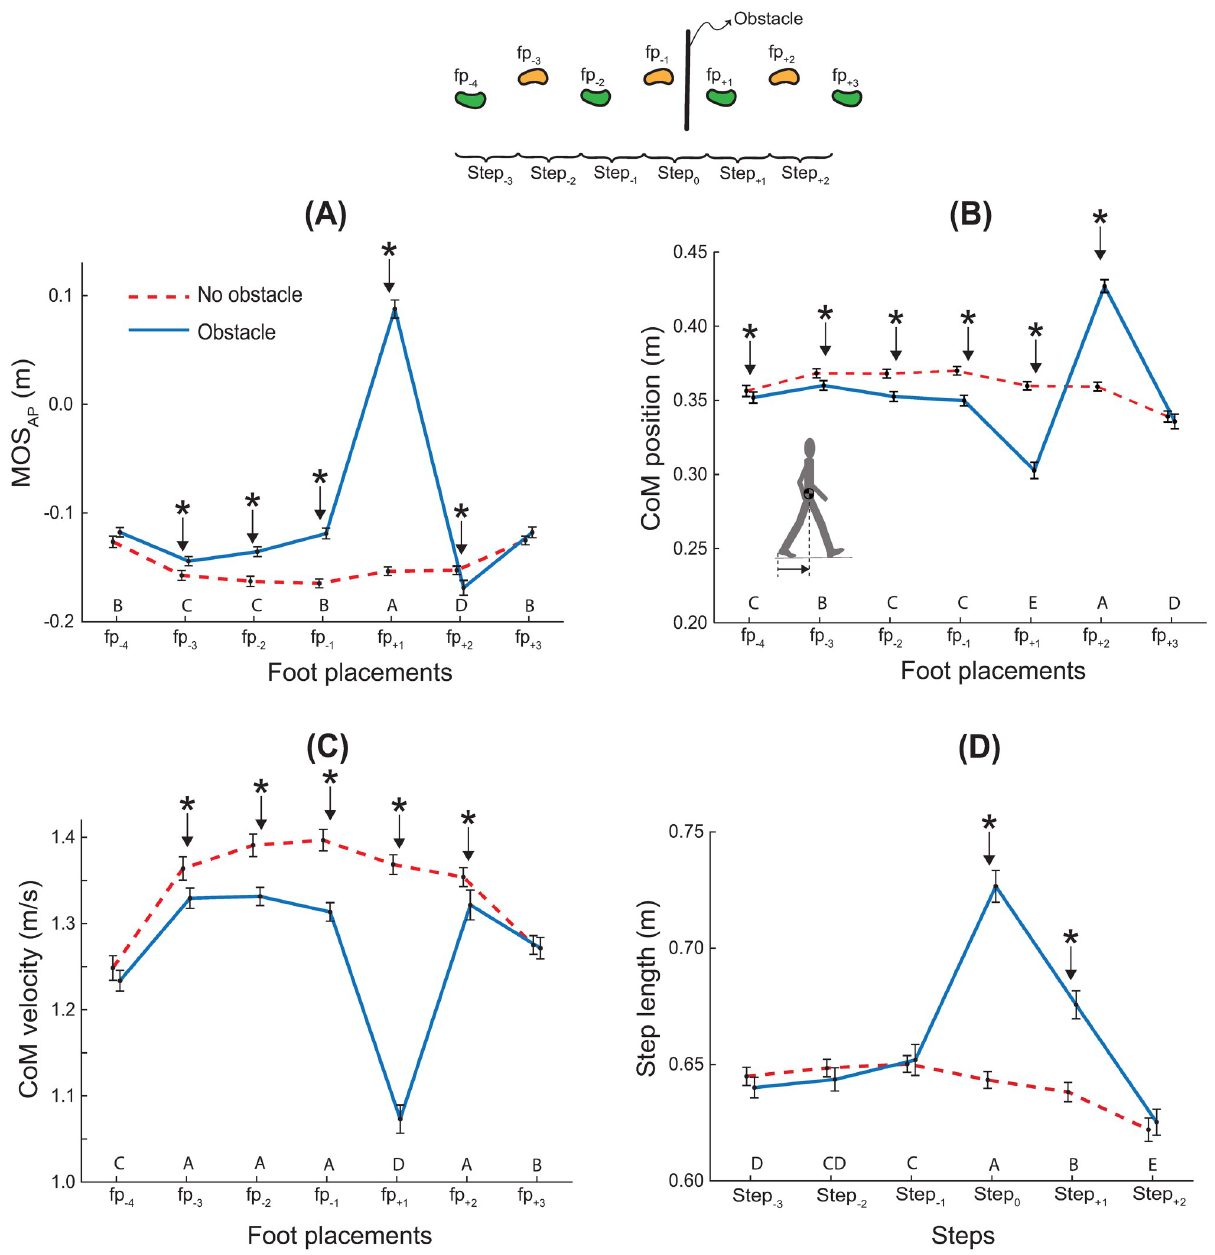
Fig 3. MOS AP and its components. MOS AP (A) , CoM position at heel contact (B) , CoM velocity at heel contact (C) and step length (D) . Data are across-subject means (N = 20), and error bars denote standard error. Asterisks denote significant task difference at that step (p < 0.05). Across-step pairwise comparisons for the obstacle-crossing task are indicated by the row of letters above the horizontal axis for each panel. Steps that do not have letters in common are significantly different from each other (i.e., A is different from B, but A is not different from AB).